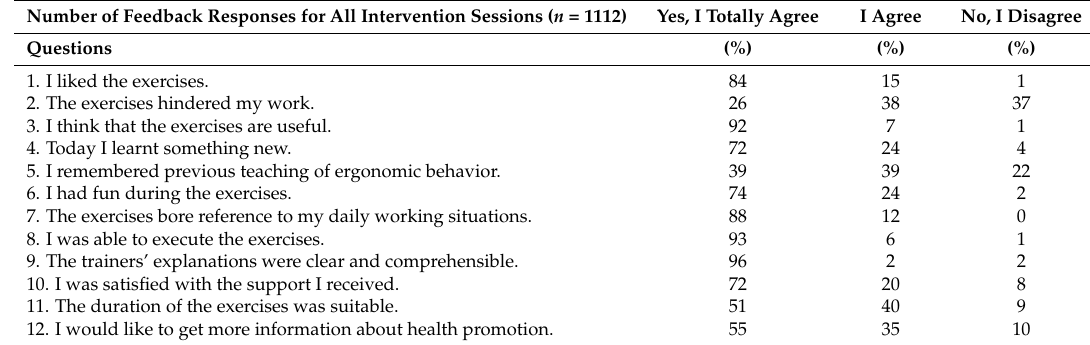
Table 5. Satisfaction with the intervention ( n =